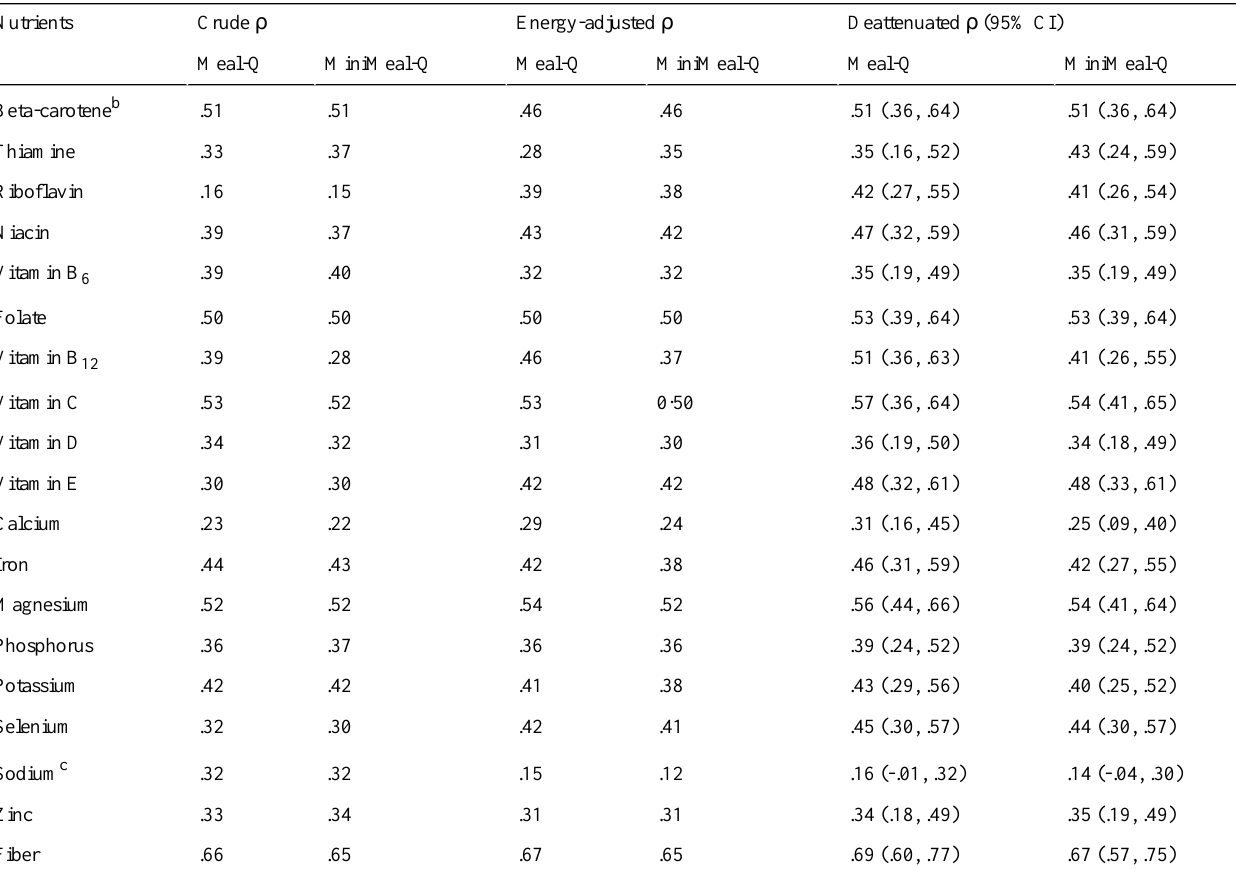
Table 5. Spearman rank correlation coefficients ( ρ ) between Meal-Q, MiniMeal-Q, and the weighed food record (WFR)